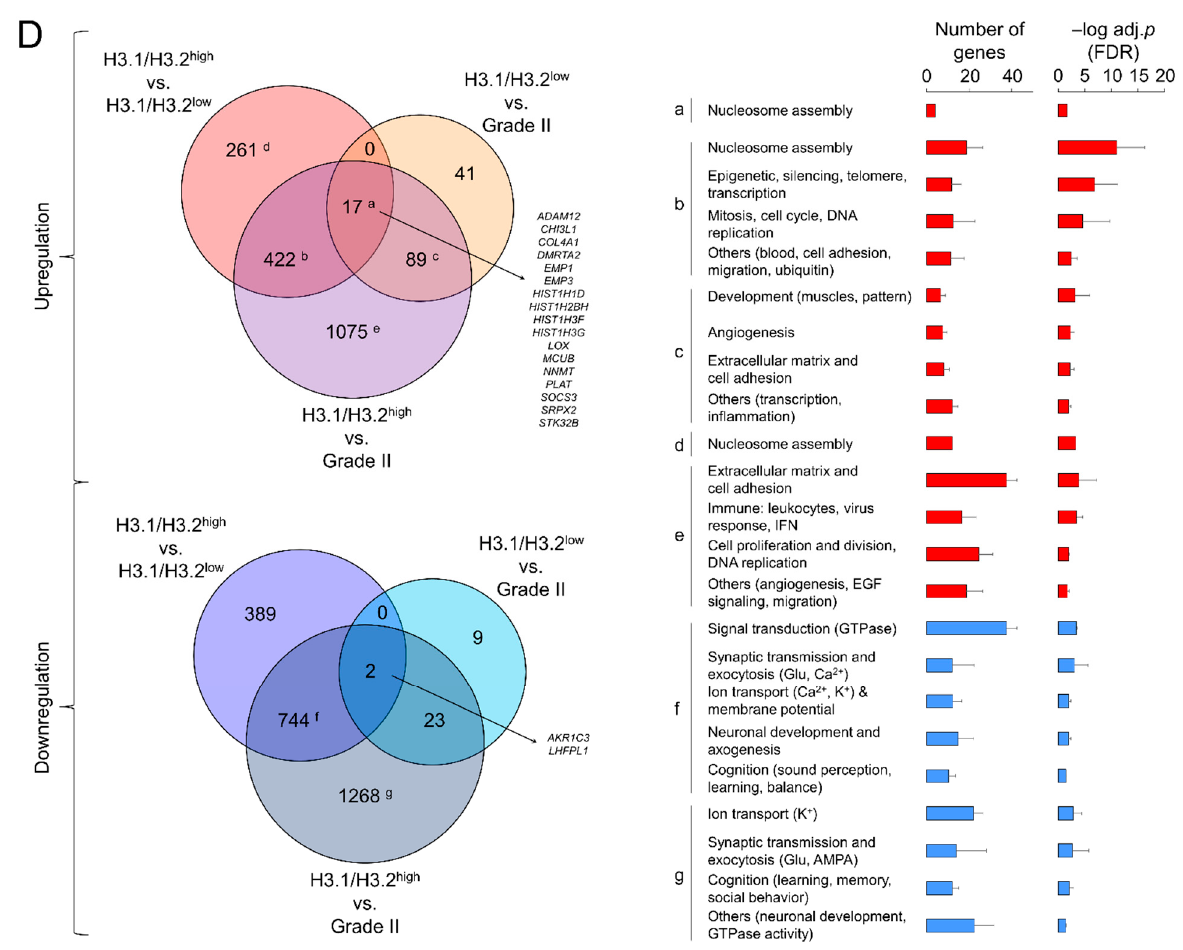
Figure 6. Differential gene expression between glioblastomas expressing low and high levels of the canonical H3 proteins. ( A ) H3.1/H3.2 protein levels in the selected samples for the differential expression analysis, classified in three groups: grade II gliomas and GB expressing low and high levels of protein (H3.1/H3.2 low and H3.1/H3.2 high , respectively). The data are expressed as the means ± SEM. Note: ** p < 0.005; Mann–Whitney U test related to grade II gliomas. ( B ) Tridimensional PCA of the samples used in the differential expression analysis considering their whole transcriptomes. ( C ) Distribution of differentially expressed genes (DEGs) obtained in the three pairwise comparisons (H3.1/H3.2 high vs. H3.1/H3.2 low , H3.1/H3.2 high vs. grade II gliomas and H3.1/H3.2 low vs. grade II gliomas) across the whole GB transcriptomes from TCGA (left) and the REMBRANDT (right) cohorts. These transcriptomes were ranked according to the significance and direction of the gene expression change compared to lower-grade gliomas and divided into bins of 500 genes. The number of down- and upregulated genes from our lists was counted in each bin. ( D ) Venn diagrams showing the overlaps between the lists of DEG (adj. p -value < 0.05) from the following comparisons: H3.1/H3.2 low vs. grade II gliomas, H3.1/H3.2 high vs. grade II gliomas, H3.1/H3.2 high vs. H3.1/H3.2 low . Letters refer to the significantly enriched GO terms (FDR < 0.05, DAVID) for each subset of genes represented as the number of genes and –log-adjusted p -value (mean ± SD); red and blue bars, upregulation and downregulation,